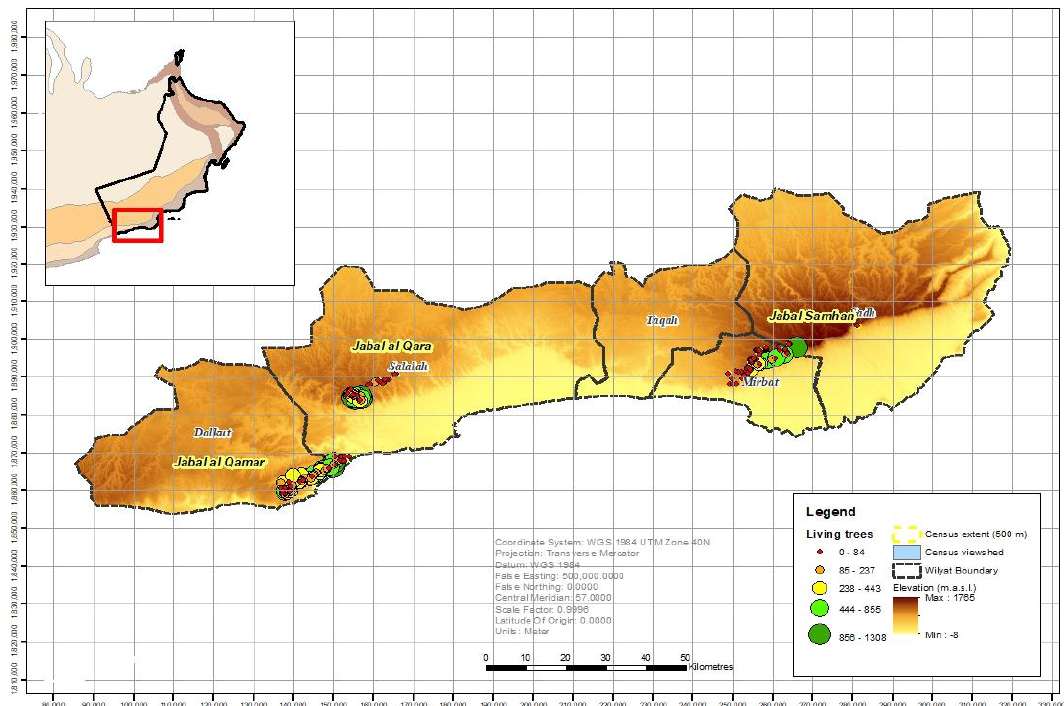
Figure 2. The overall distribution of Dracaena serrulata across the Dhofar Mountains including Jabal al Qamar, Jabal al Qara, and Jabal Samhan as recorded in the project census, January 2018.